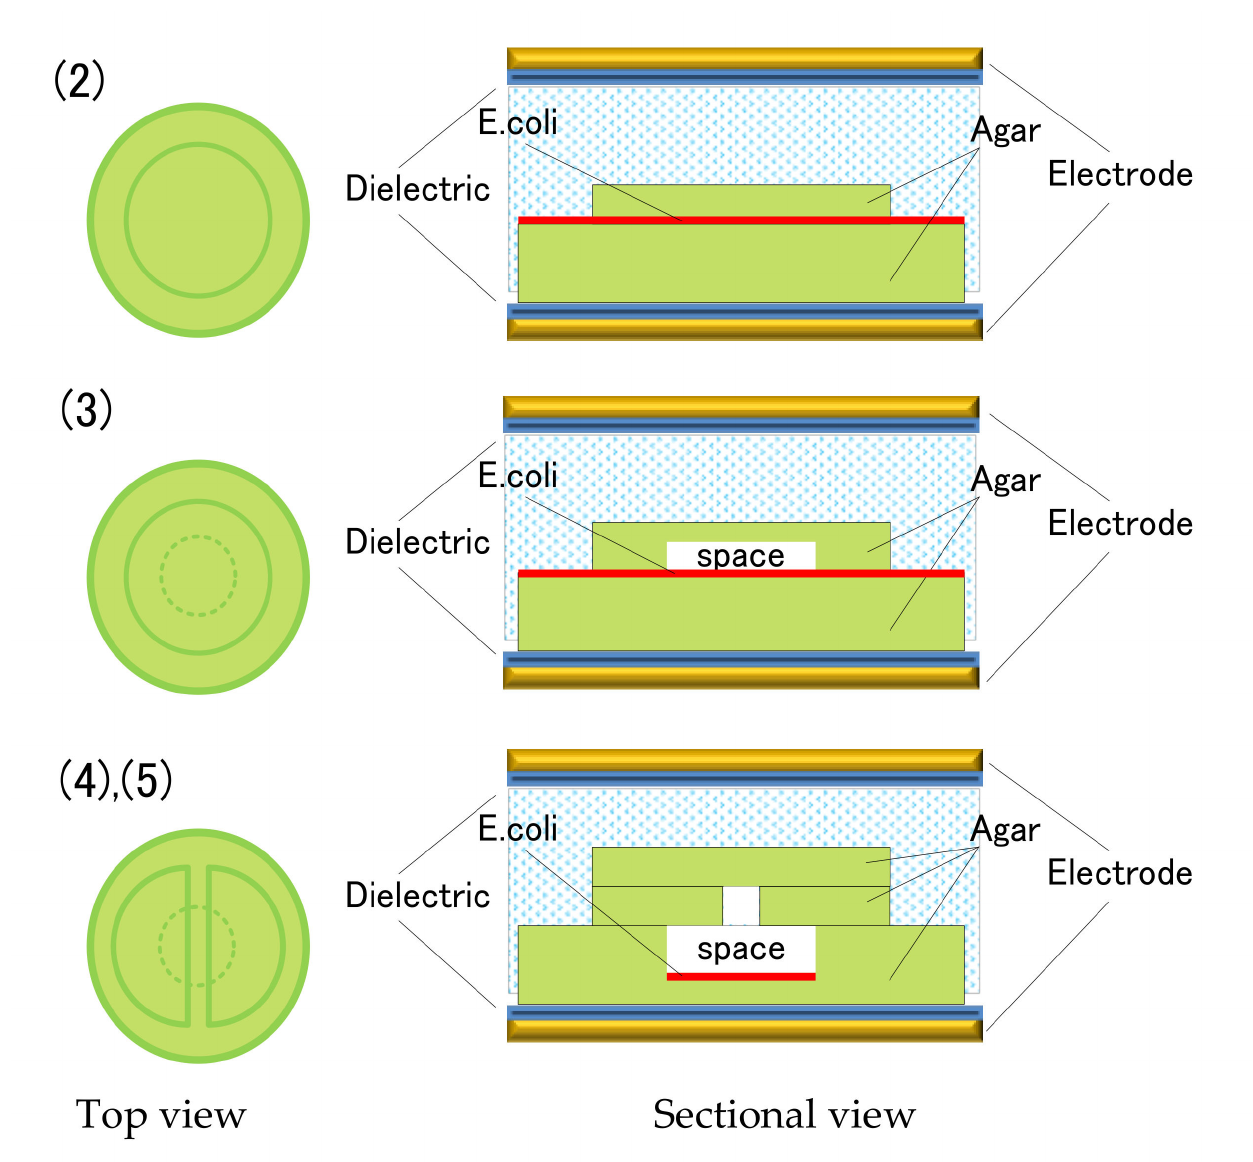
Figure 8. Agar medium configurations and positions of E. coli